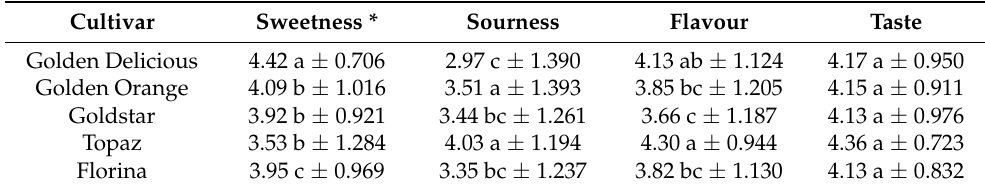
Table 4. Consumer evaluation of the fruit of five apple cultivars for internal quality attributes— sweetness, sourness, flavour and taste (mean ± standard